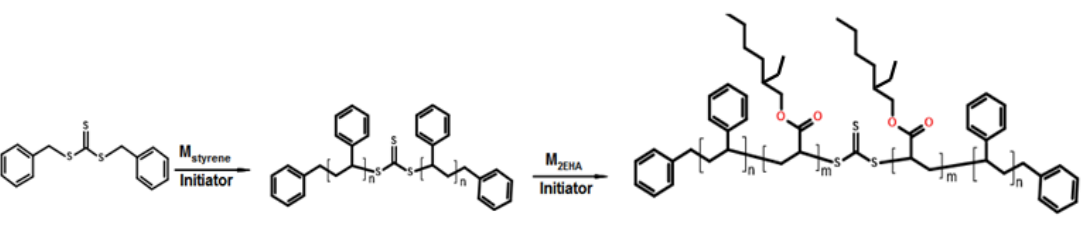
Figure 1. Scheme of p(St-2HA-St) block copolymer formation.